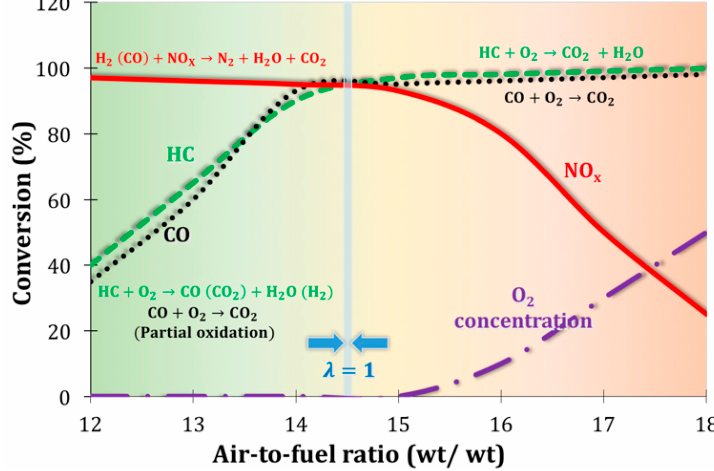
Figure 2. The TWC conversion profile as a function of air-to-fuel ratio.